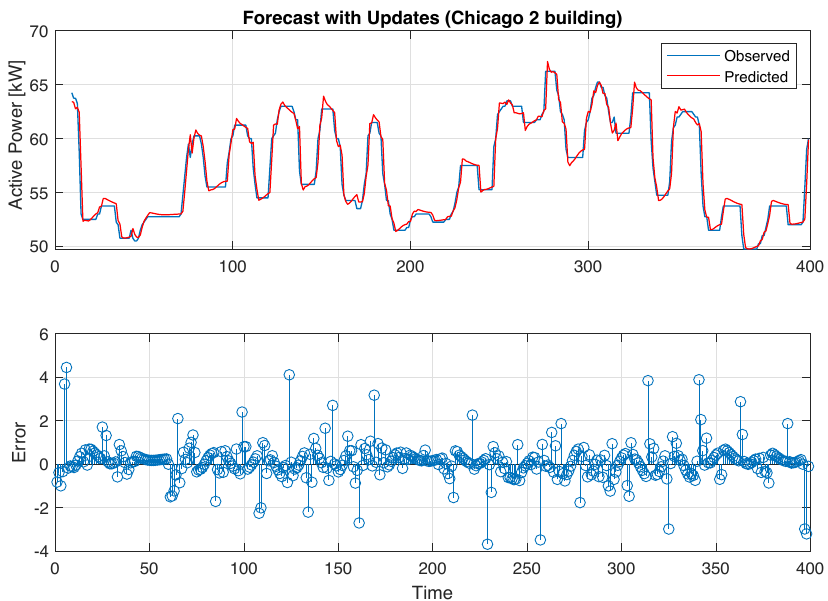
Figure 7. Building load forecasting with 50 unit RNN LSTM: Chicago 2.